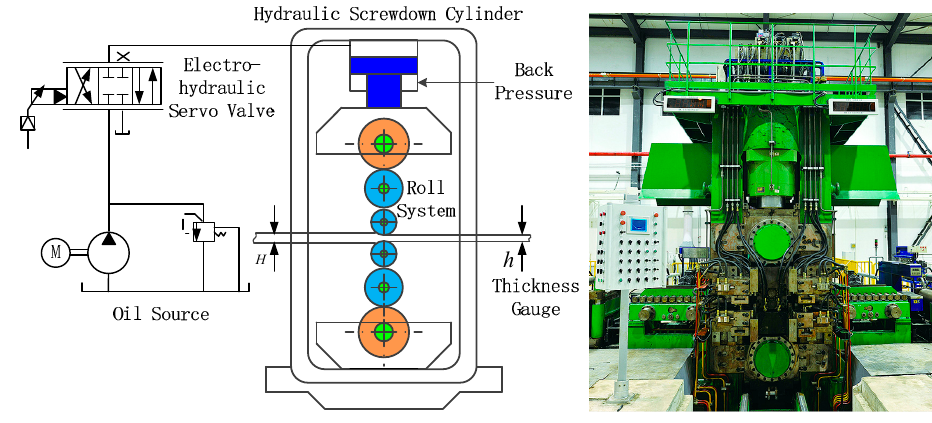
Figure 1. Structural diagram of rolling mill.